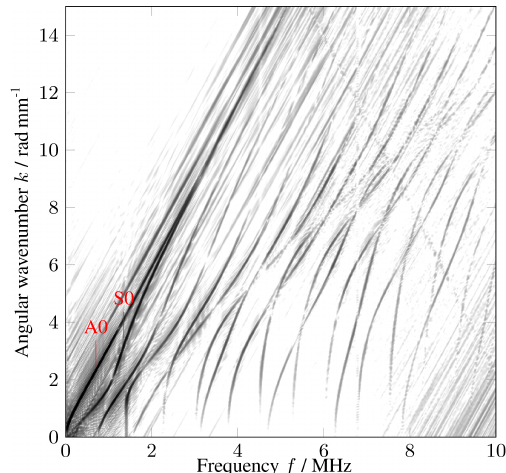
Figure 10. Dispersion map of a copper plate (thickness 1.53mm). Generated by applying the two-dimensional FFT to spatially and temporally resolved